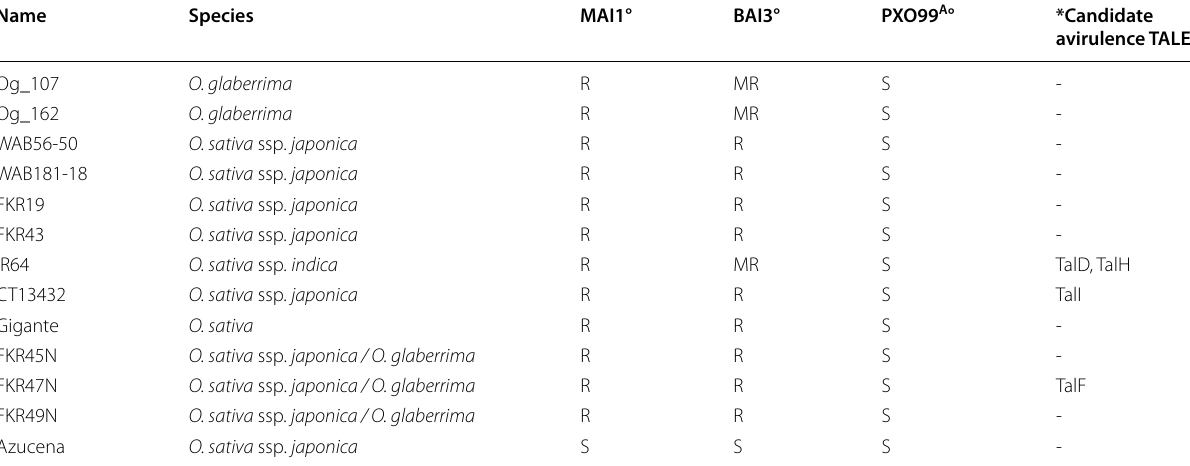
°Resistance or susceptibility of rice to Xoo is expressed as a result of lesion length measurements 15 days after inoculation. Resistant (R), x < 5 cm; moderately resistant (MR), 5 cm < x < 10 cm; moderately susceptible (MS), 10 cm < x < 15 cm; susceptible (S), x > 15 cm *Rice accessions were inoculated with PXO99 A carrying each of the nine tal genes of MAI1. (-) means no candidate avirulence TALE